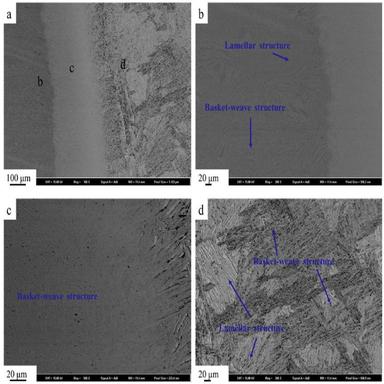
SEM images showing the morphology and the variation of microstructure in the overlap zone for the 2.0 mm overlap specimen: (a) the interfacial zone of 2.0 mm overlap specimen; (b), (c) and (d) are all magnified images shown in a).